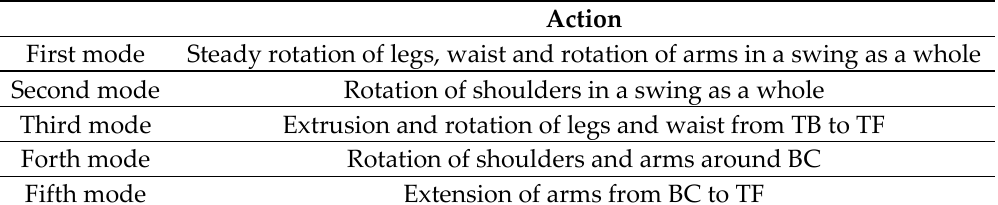
Table 2. Relationship between each swing composed mode and each action [10,11].